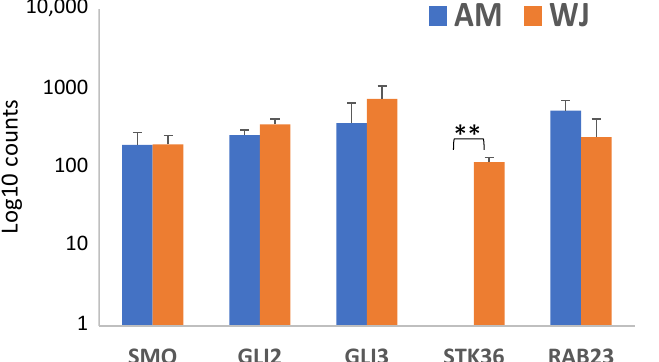
Figure 4. Hedgehog signalling genes expressed in both AM- and WJ-MSCs under basal condition. Data represented mean counts ± SD. Asterisks (**) represent statistical significance p < 0.005.